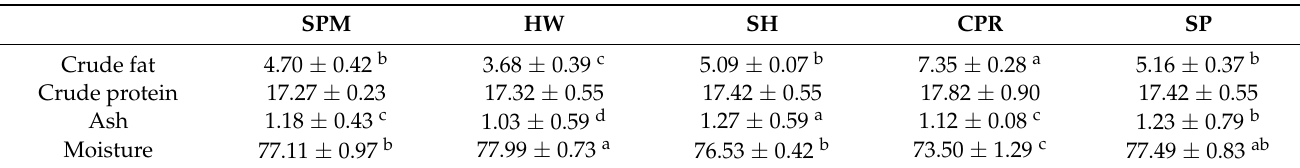
Table 5. The muscular proximate chemical composition in five species of common carp (fresh flesh weight, Table 4. Morphological index and muscle texture characteristics in five species of common carp.